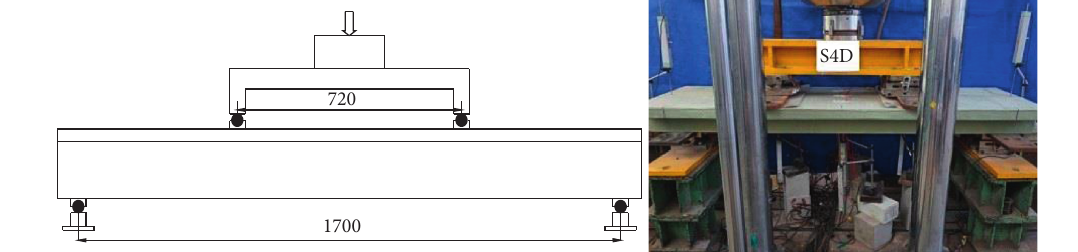
Figure 3: Test setup (units: mm).